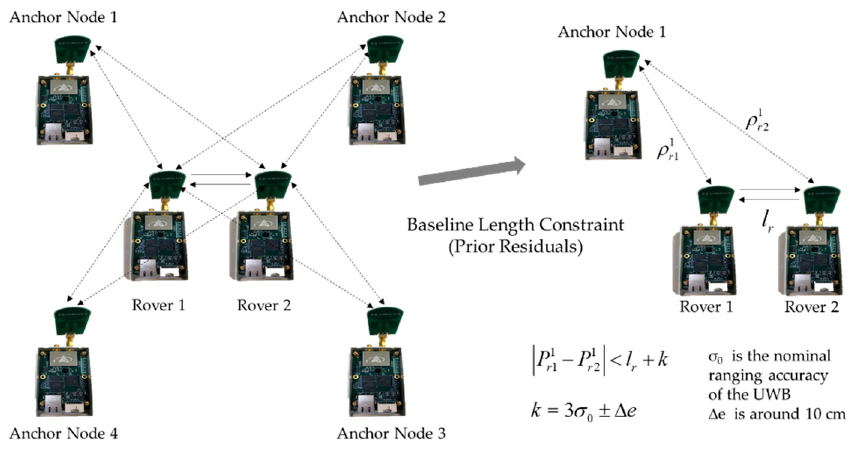
Figure 2. Schematic diagram of prior baseline constraint. The second one is the posterior baseline residual constraint. After obtaining the coordinates of the two rovers, the baseline length l c can be calculated. The difference between the calculated value l c and the truth value l r is defined as the baseline residual. The baseline residual can be used to further optimize the positioning results. If the baseline residual is greater than 3 σ , the positioning result is considered unreliable. The anchor node with large ranging errors is found by eliminating the anchor nodes one by one. σ can be obtained through a large number of experiments, and can also be set according to the actual positioning requirements. For example, if the user needs the positioning accuracy to be within 5 cm, the σ can be set to 5 cm. However, this value should not be less than 2.3 cm of p440 nominal positioning